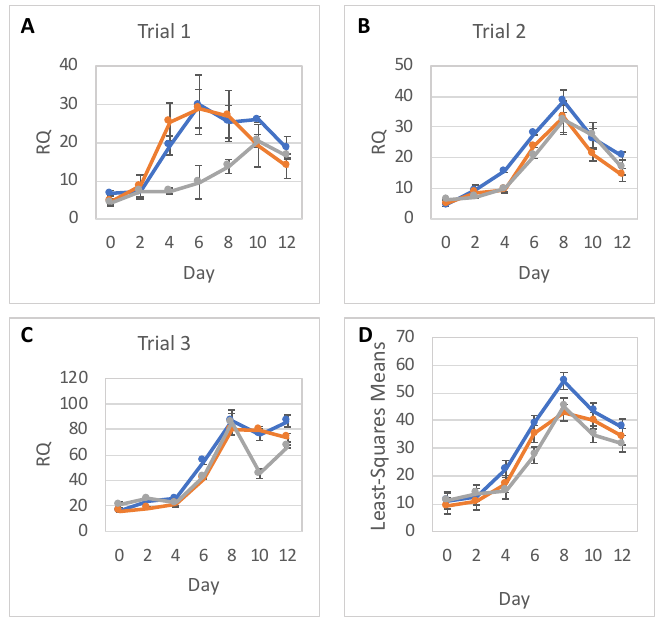
Figure 4. NES gene expression. NES relative to TBP RNA expression (RQ) in hESCs during their differentiation into NPCs in three independent trials ( A – C ) in 0-dose (blue), low-dose (orange), and high-dose (grey) samples; error bars show standard deviations of experimental measurements. ( D ) Statistical analysis of NES expression data; error bars show 95% confidence limits for the least square means of NES RQs in 0-dose (blue), low-dose (orange), and high-dose (grey) samples from all trials and with replicates combined. Table 3. Difference between 0-dose and low-dose groups in least square means of NES RNA expression according to day.